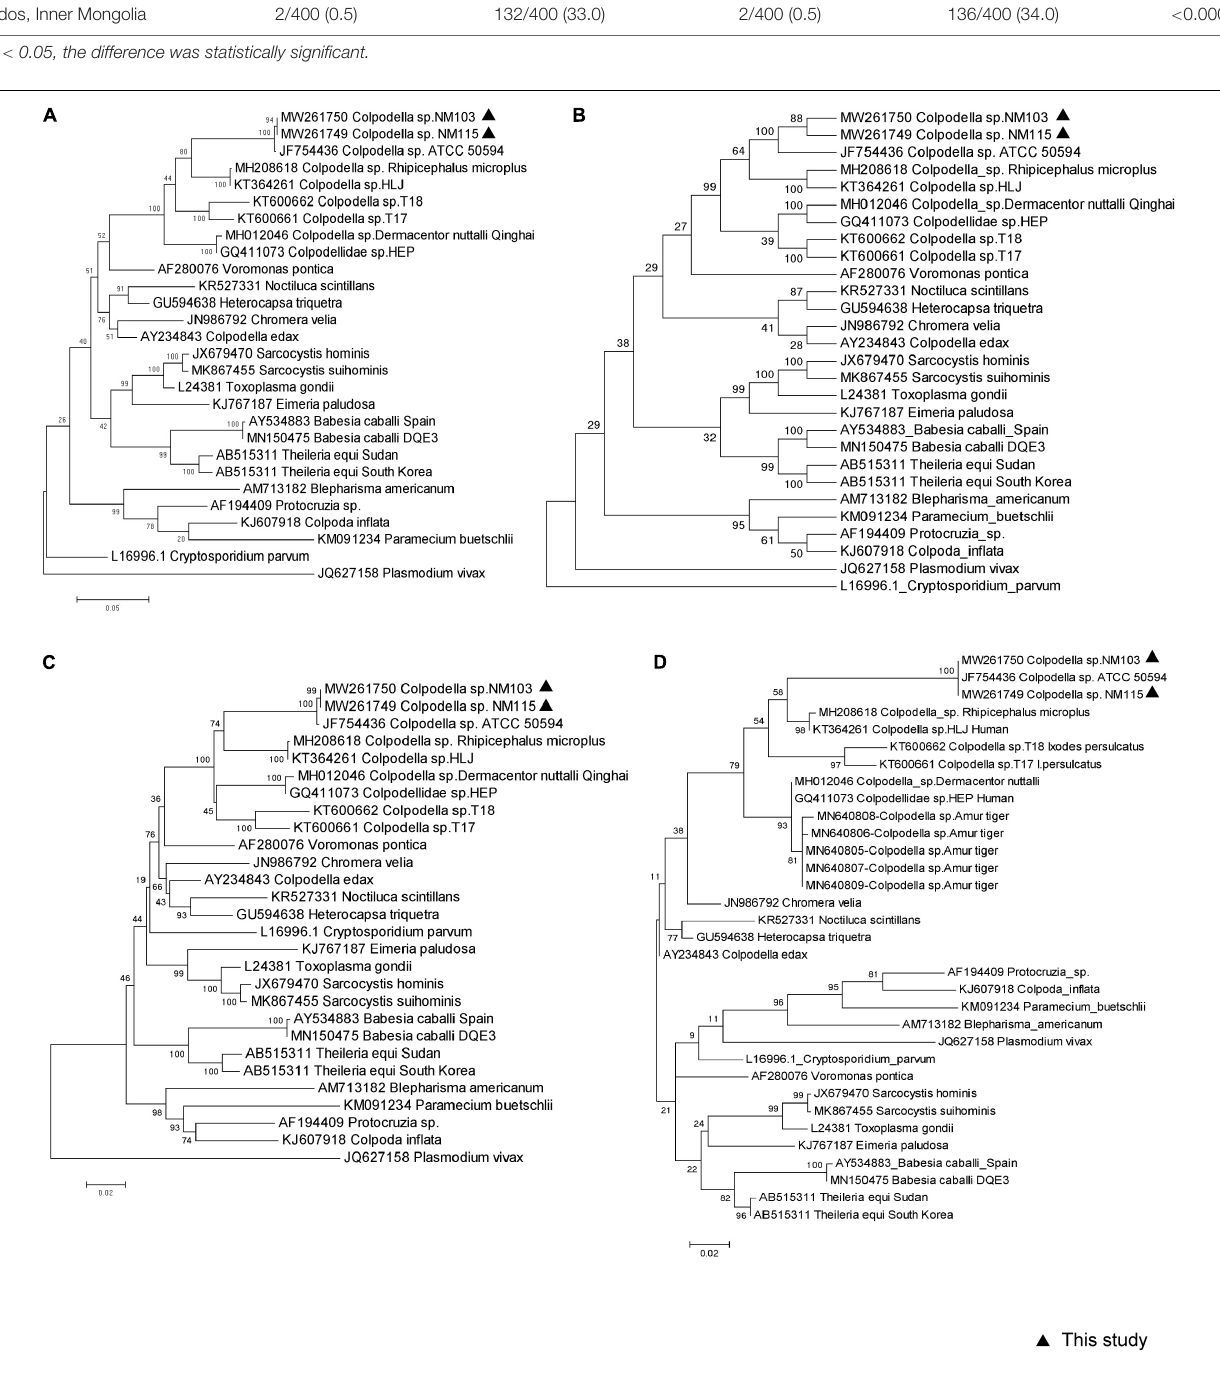
Frontiers in Microbiology |